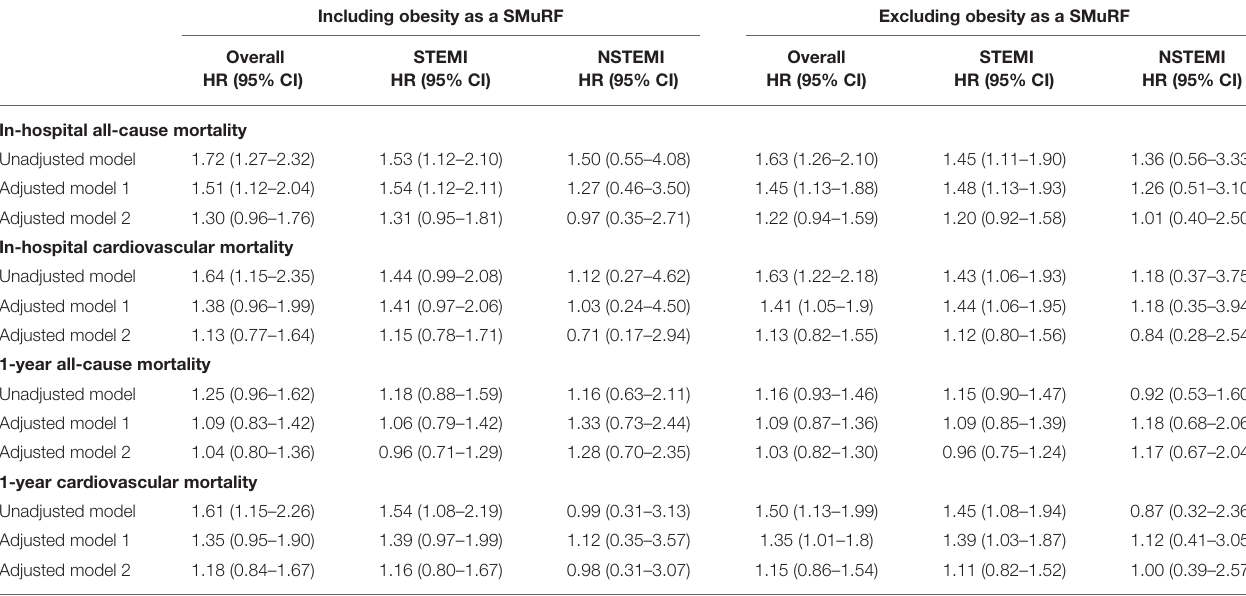
TABLE 3 | Risk of death among SMuRF-less AMI patients compared to those with at least one SMuRF (reference). Including obesity as a